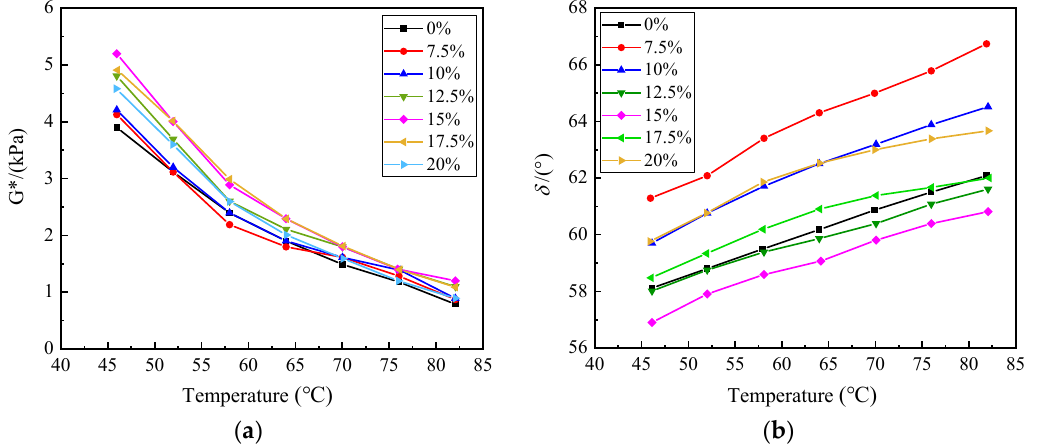
Figure 8. ( a ) The complex modulus of different content of RHB, ( b ) phase angle of different content of RHB.